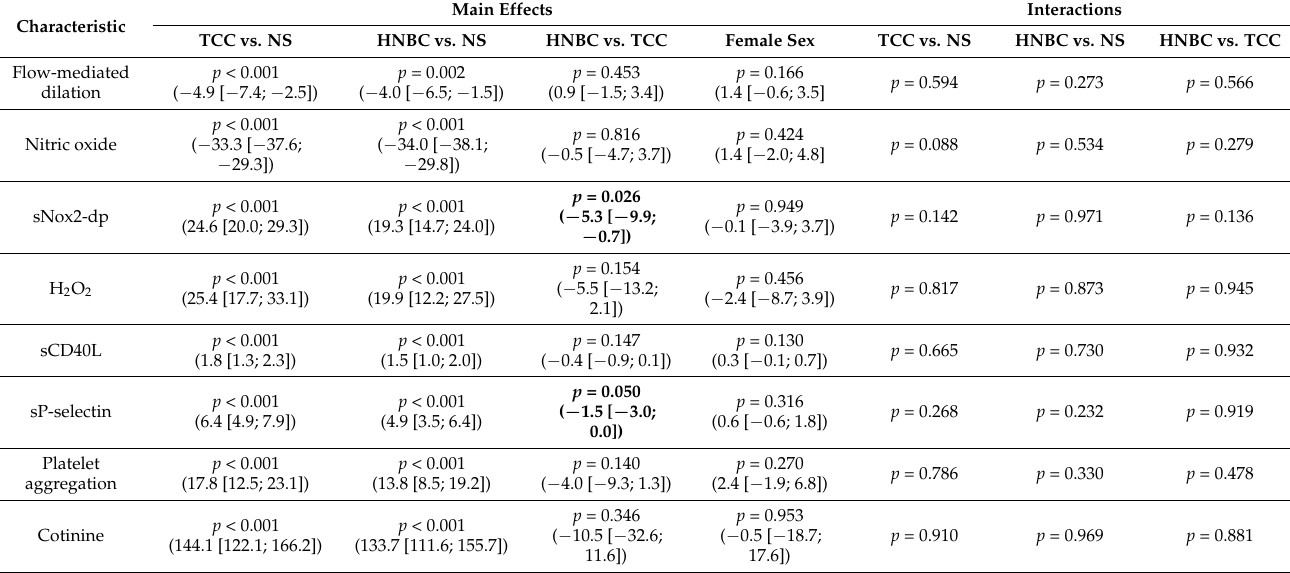
Table 5. Multivariable regression models, with and without interaction term